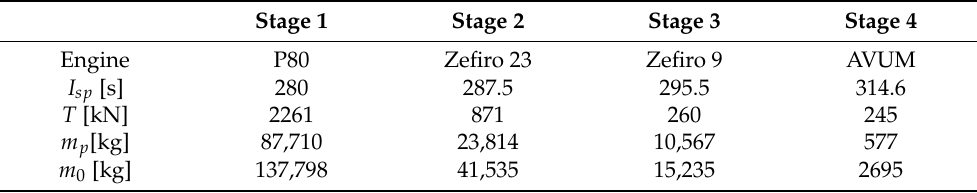
Table 8. Vega rocket characteristics.